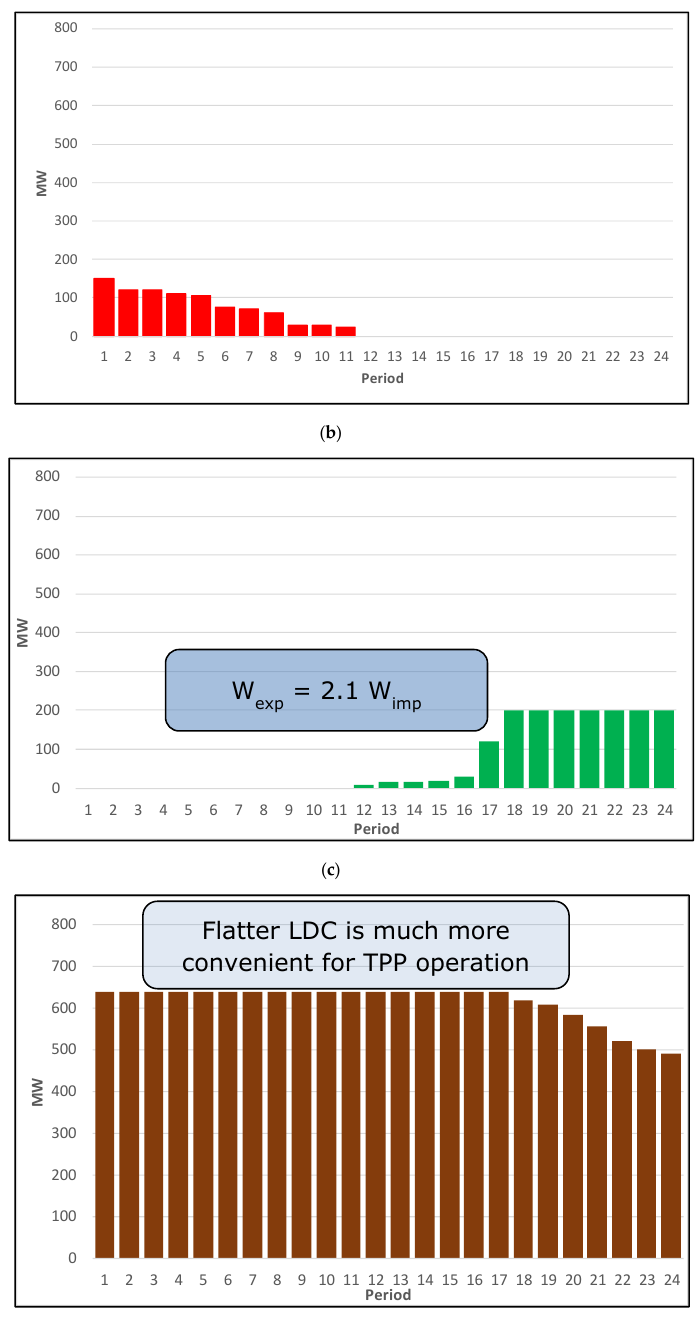
Figure 4. Alterations in resulting system LDC for scenario A: ( a ) daily LDC, ( b ) peak imports, ( c ) off-peak exports, ( d ) new LDC.